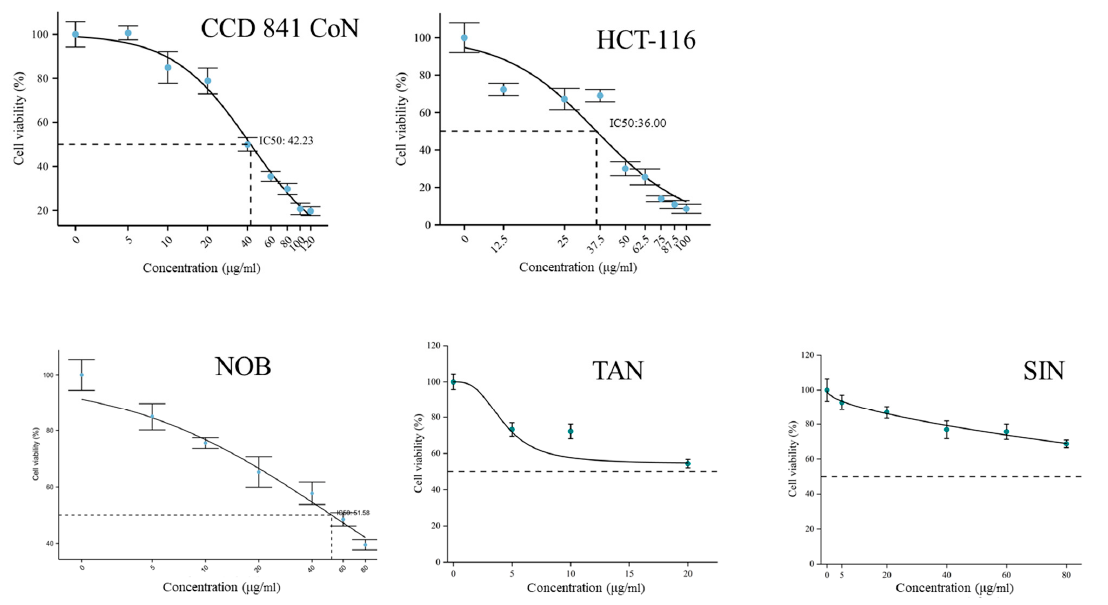
Figure 6. Influences on cell viability caused by PMF